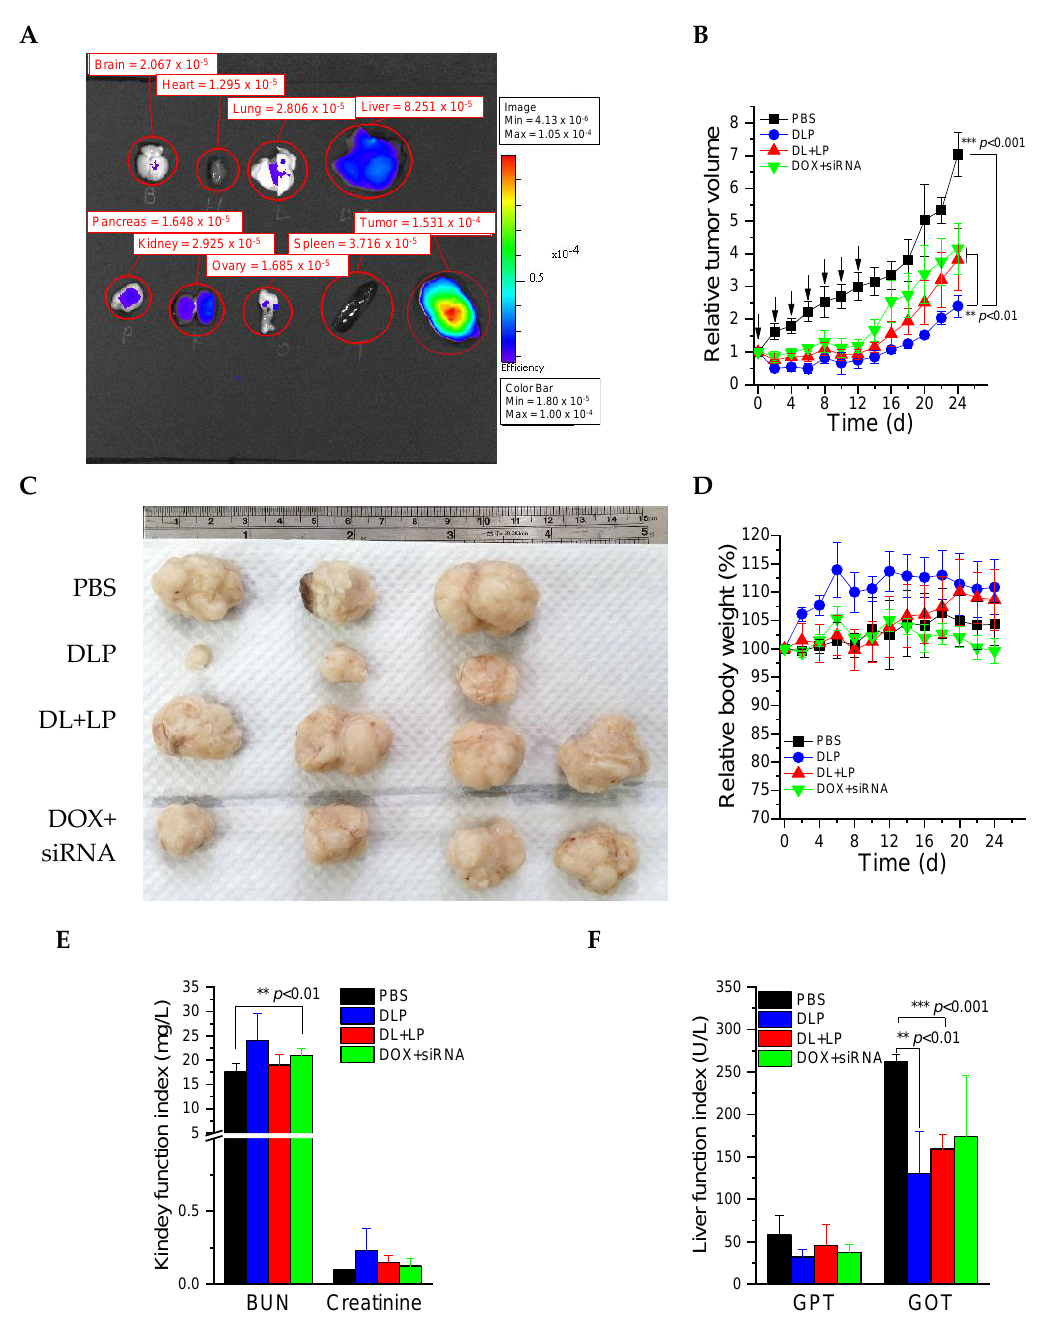
Figure 8. In vivo test of lipopolyplexes. ( A ) The biodistribution of Cy5.5-labeled lipopolyplexes in each organ after treatment for 24 h. ( B ) Relative tumor volume changes of BALB/c nude mice after treatment for 24 days. ( C ) Images of real tumor volume after treatment for 24 days. ( D ) Relative body weight changes of BALB/c nude mice after treatment for 24 days. ( E ) Kidney function and ( F ) liver function of BALB/c nude mice after treatment for 24 days. The drugs were administered on day 0, 2, 4, 6, 8, 10, and 12. PBS: mice treated with PBS; DLP: mice treated with DLP; DL+LP: mice treated with DOX-loaded liposomes and lipopolyplexes; DOX + siRNA: mice treated with free DOX and free FAK siRNA. The treated dosages of DOX and siRNA were 2 mg/kg and 10 µmol/kg, respectively. Data were presented as mean ± SD ( n = 4). ** p < 0.01 and *** p < 0.001.